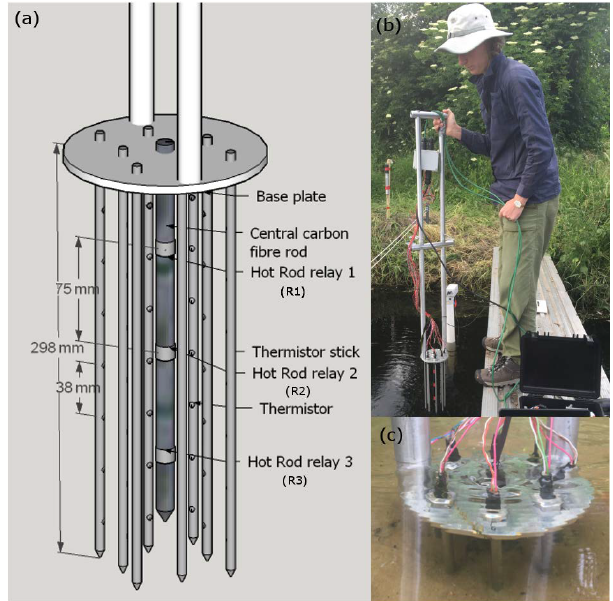
Figure 1. (a) Detailed design of the active HPS Hot Rod with three heating elements (R1, R2 and R3) on the central carbon-fibre rod surrounded by 56 temperature sensors at two distances from the central heat source (28 and 47mm). (b) and (c) Installation of the Hot Rod in a small stream characterised by shallow bedforms.